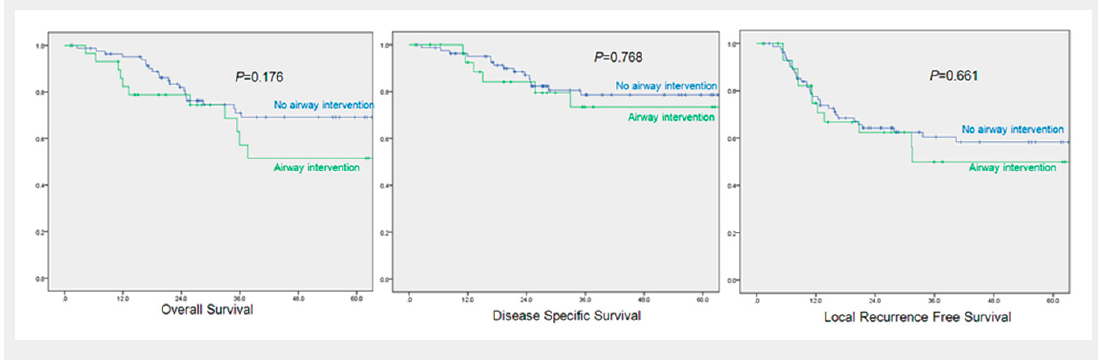
Pretreatment airway intervention vs no airway intervention: 5-year